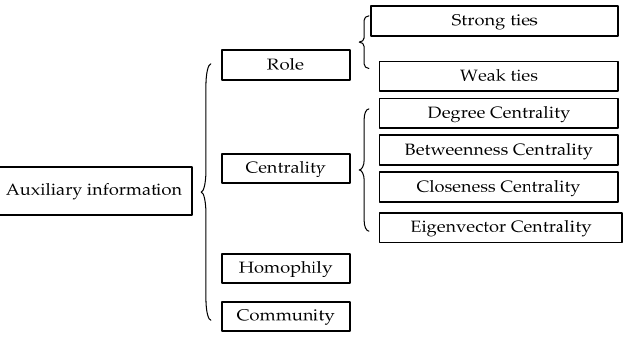
Figure 7. Auxiliary information graph.